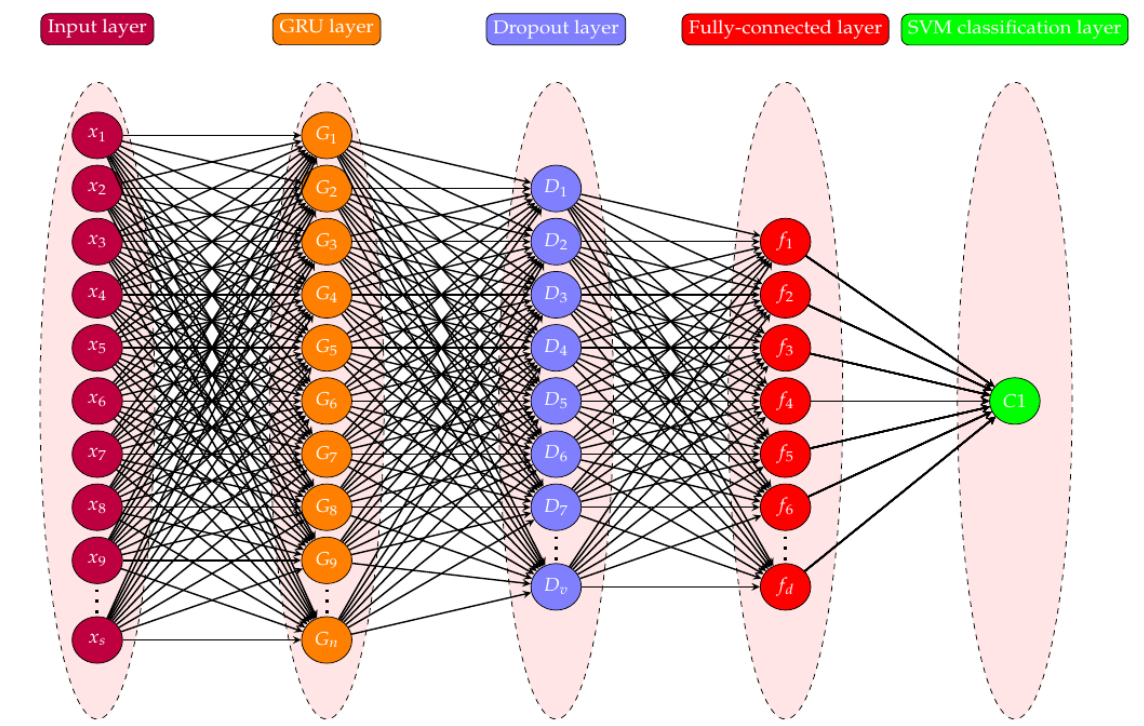
Figure 4. Neural network representation of proposed GRU-SVM